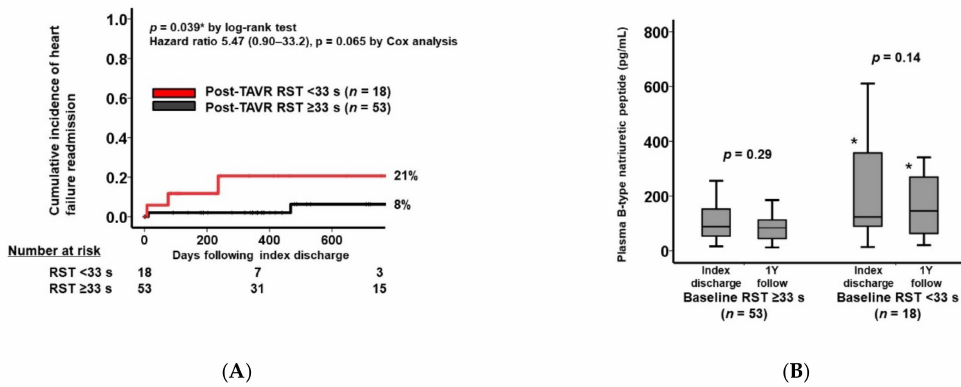
Figure 6. The cumulative incidence of heart failure readmissions stratified by the post-TAVR RST ( A ) and the trend in plasma B-type natriuretic peptide levels following index discharge ( B ) * p < 0.05 compared with the baseline RST ≥ 33 s